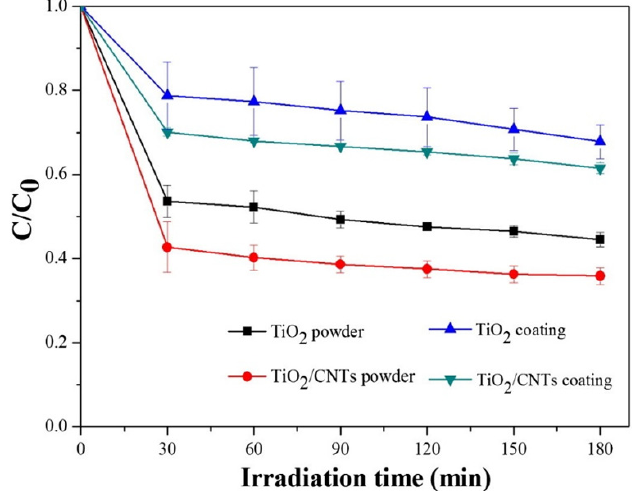
Figure 15. Initial hydrogen consumption rates during nitrobenzene hydrogenation (3 bars, 40 °C) for the different catalysts. P refers to the initial powder, P-p to the scrapped powder, F to the coated foam, and M to the crushed coated monolith [188].